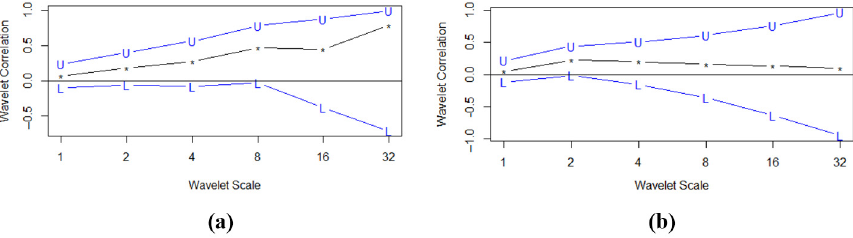
Figure 5. Wavelet correlation between WTIR and CNXR and